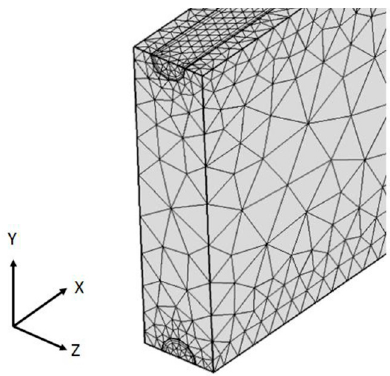
Figure 5. Meshing scheme of a single periodic unit of the MRHE. The maximum temperature and the temperature gradient decreased when the length of first reaction zone was reduced from 0.050 to 0.025 m (Figure 6). At the same time, the mean temperature in the second reaction zone only slightly increased. A length of 0.030 m corresponds to the minimum temperature non-uniformity over the entire reactor. The heat generation in the first section and in the second section became equal (Figure 4a). Therefore, a two-zone reactor with a channel length of 30 mm (first section) and 170 mm (second section) was selected for subsequent design optimization.